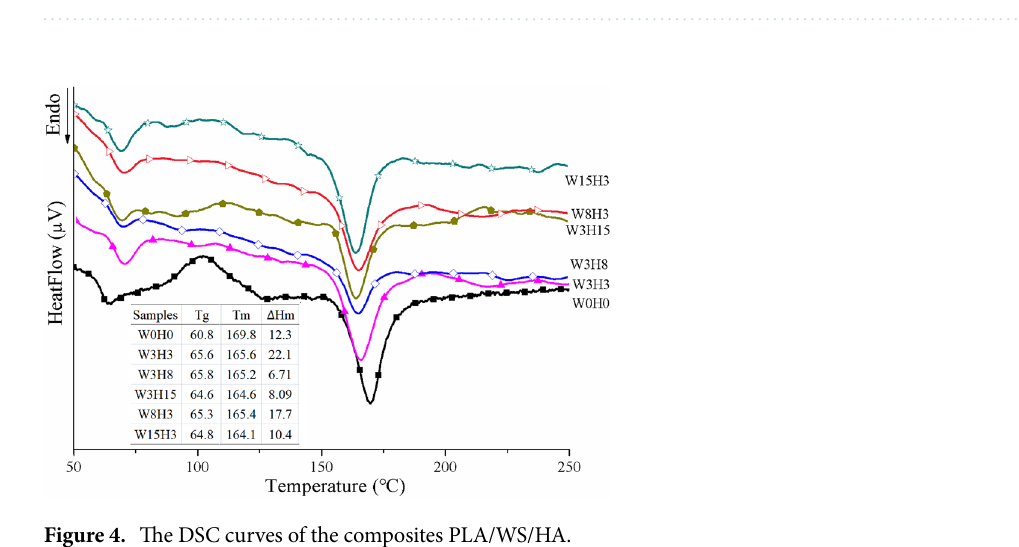
Figure 3. FTIR spectra of HA treated with various concentrations of 0 wt% (HA-0), 1 wt% (HA-1), 2 wt% (HA- 2) and 3 wt% (HA-3) of KH550.